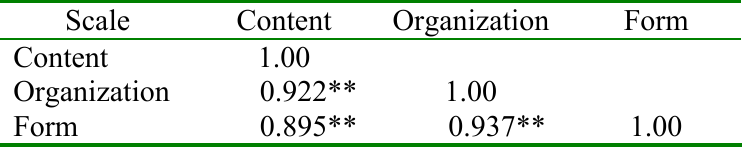
Correlation Matrix for the Writing Test ( N